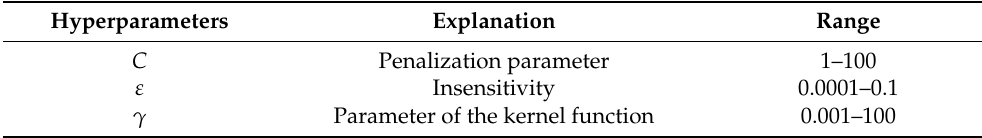
Table 4. SVM hyperparameters and their tuning ranges.